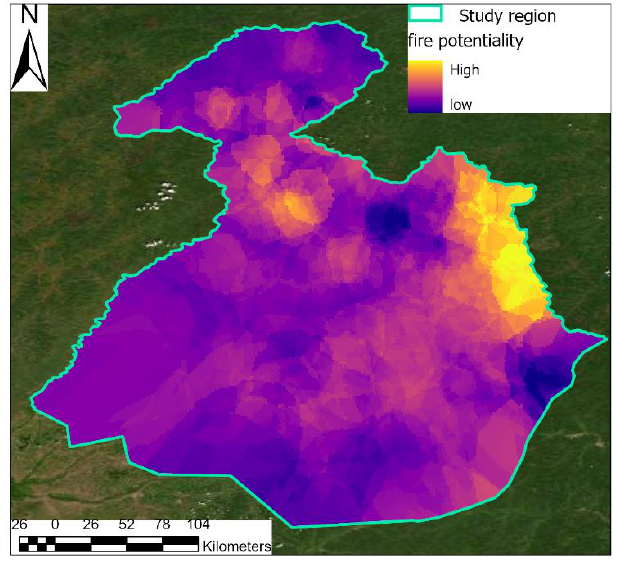
Figure 14. Prediction of large lightning fire.